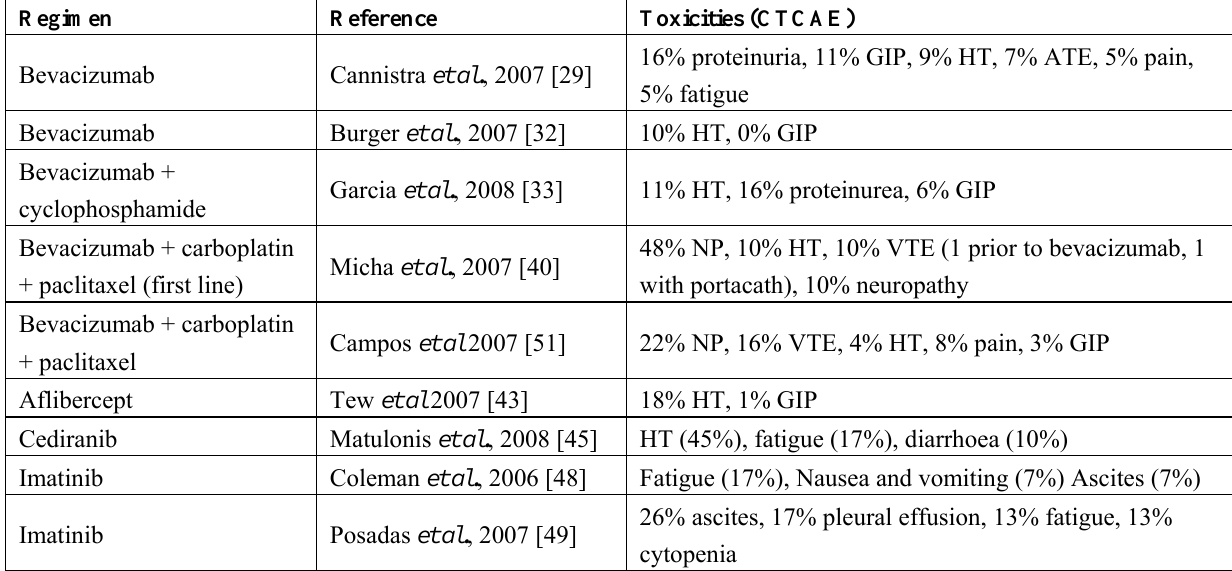
Table 3. Toxicity profile of antiangiogenic